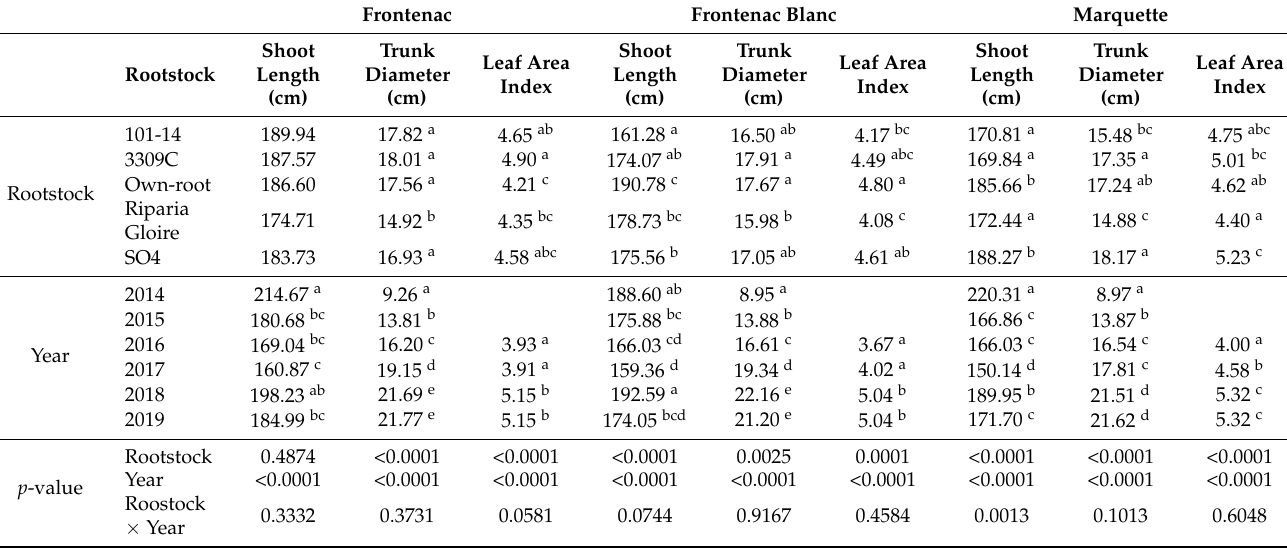
Table 5. Effect of rootstock on grapevine vigor of the three cold hardy hybrids. Frontenac Frontenac Blanc